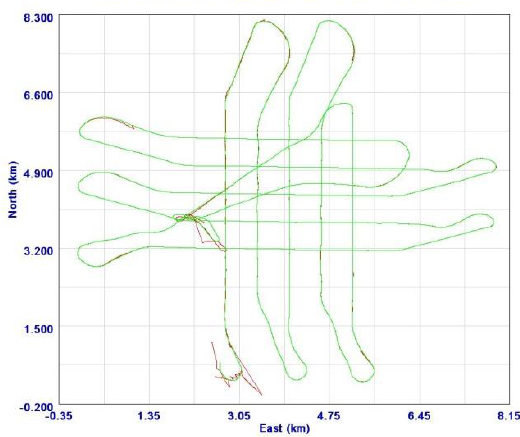
Figure 12 The EOP result